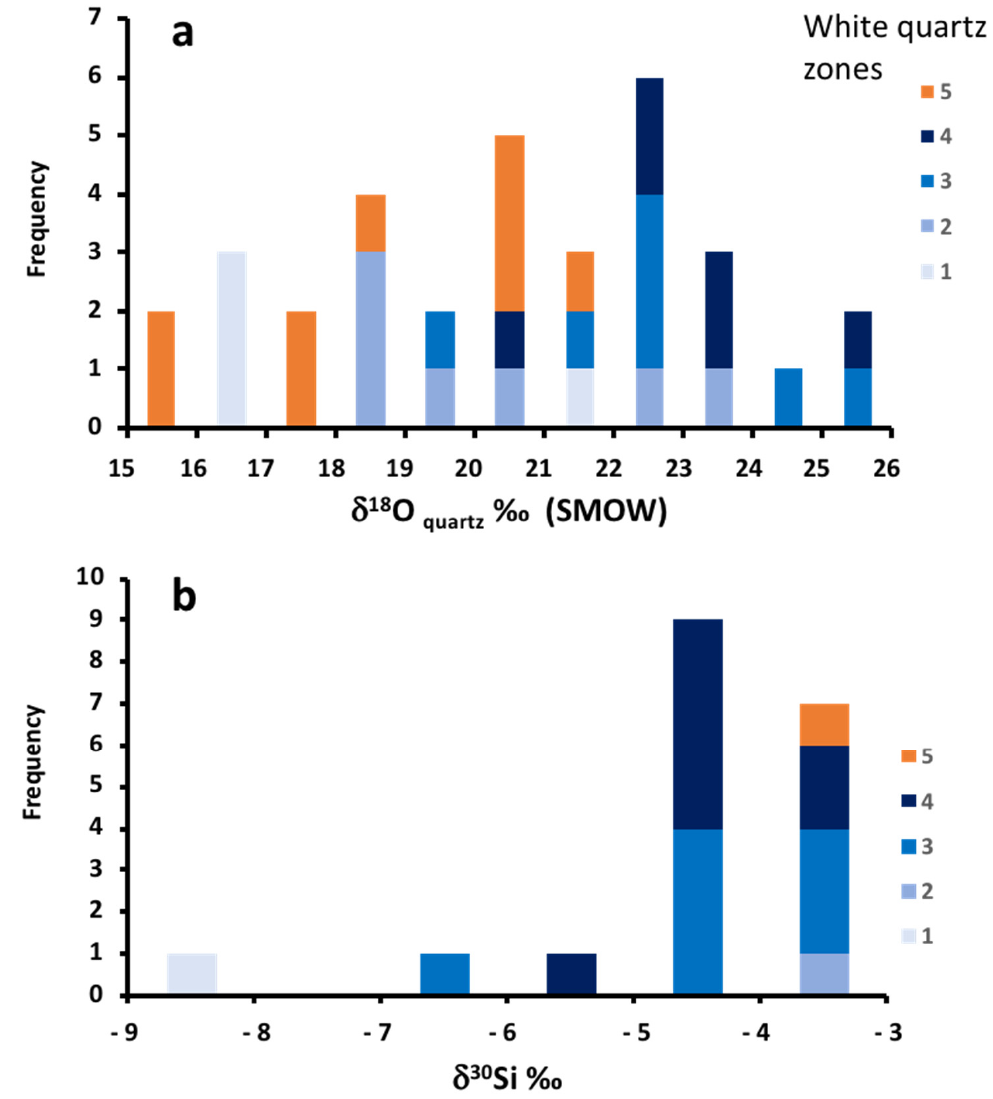
Figure 10. ( a ) δ 18 O values along two profiles across the white quartz from the edge to the centre of the vug (five zones described in Figures 4f and 9). ( b ) δ 30 Si quartz (‰) along the same pro fi les.